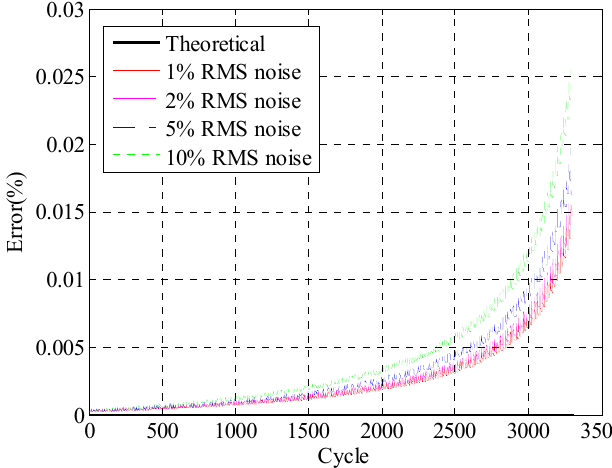
Figure 15. Error analysis of crack length growth evaluation using theoretical and reconstructed stress responses under different RMS noise levels.